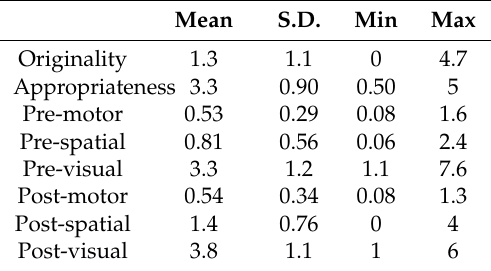
Table 1. Descriptive statistics.